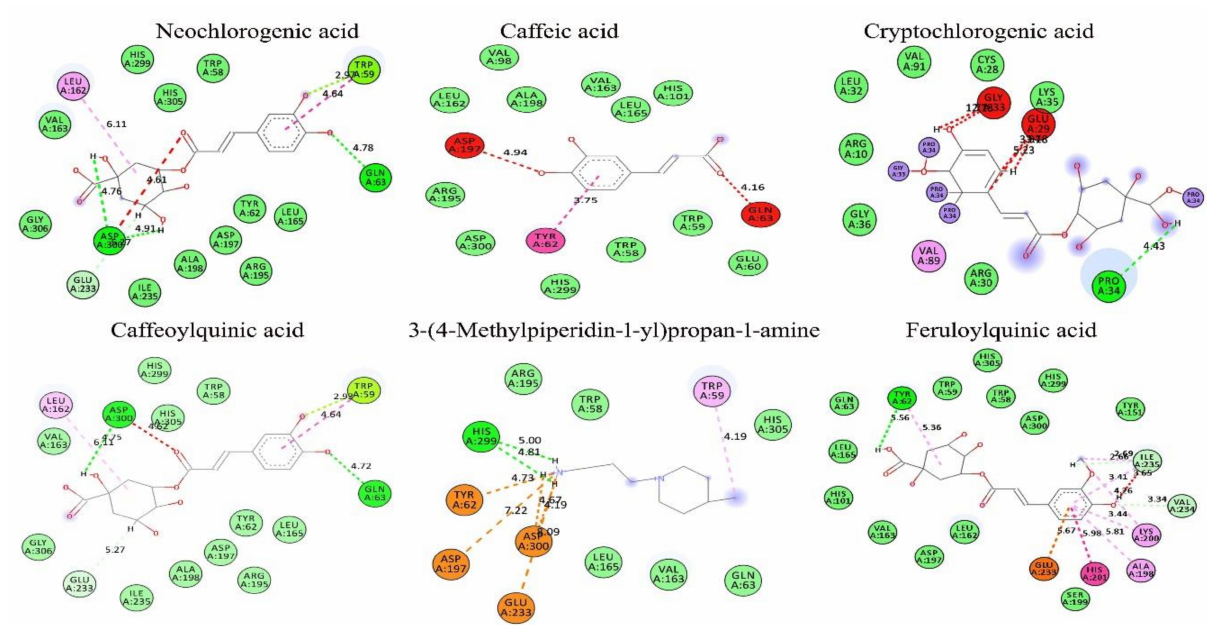
Figure 8. In silico docking analysis of isolated compounds from Ht-EAE with anti-diabetic target molecule of α